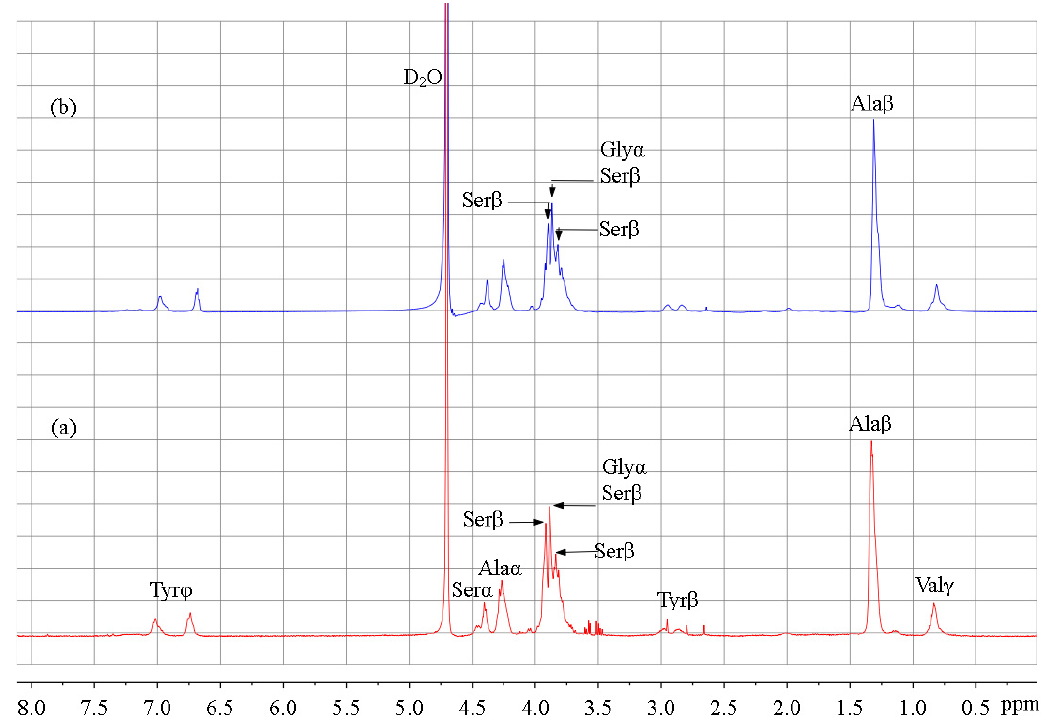
Figure 5. 1 H NMR spectra of ( a ) SF and ( b ) SSF.